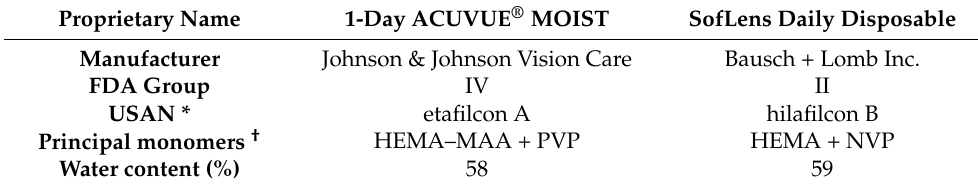
Table 1. Contact lens material types and